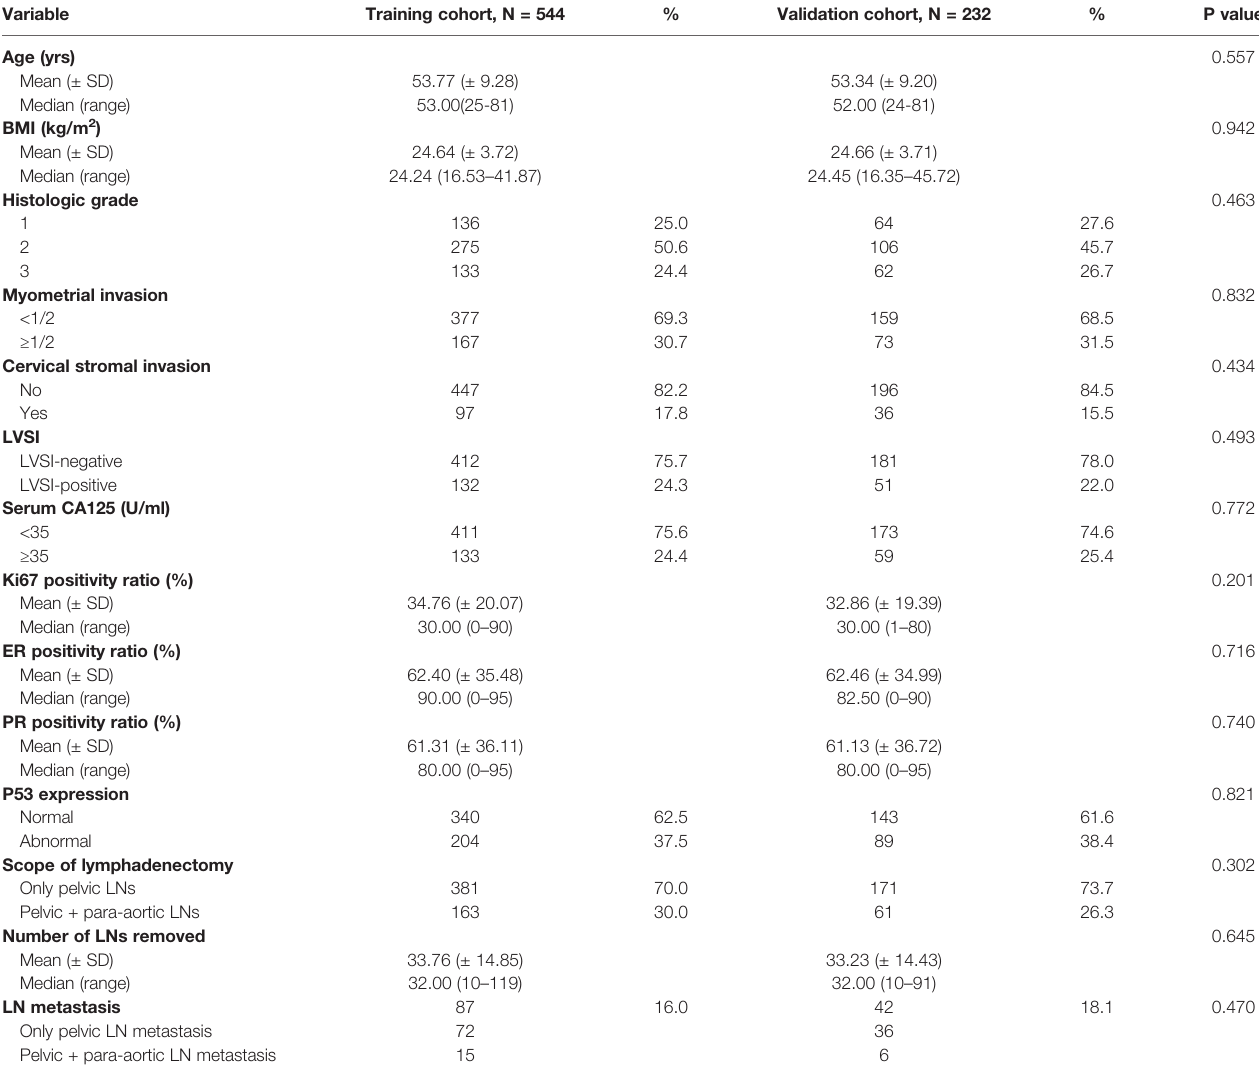
TABLE 1 | Baseline characteristics of the training and validation cohorts. Variable